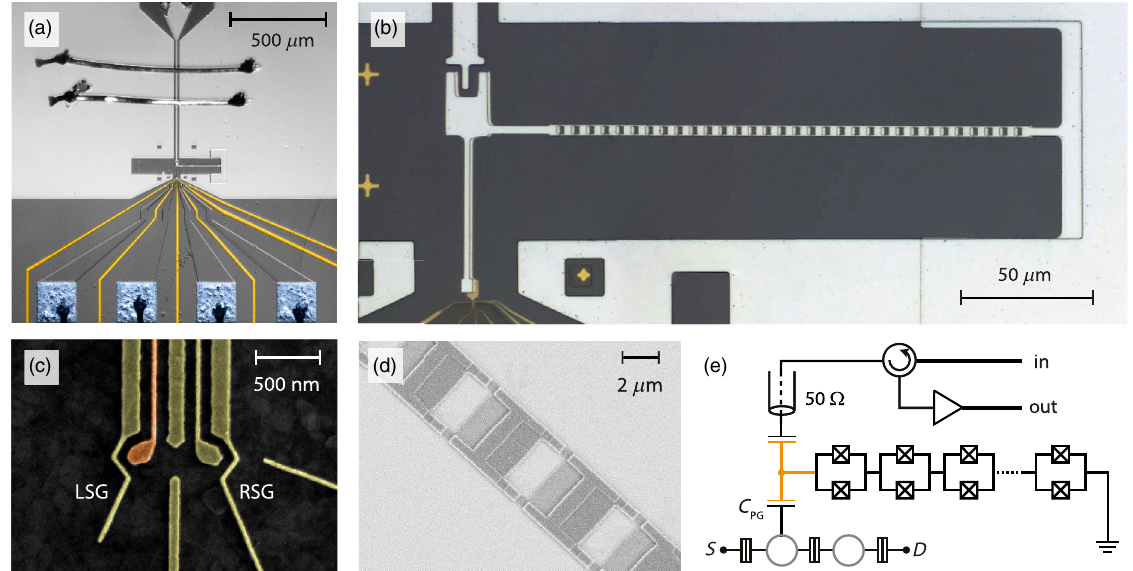
FIG. 1. Sample and simplified circuit diagram. (a) False-color optical micrograph of a representative device indicating the substrate (dark gray), the superconducting structures (light gray), the gold top gates (yellow) forming the DQD, and its source and drain leads and contacts (blue). (b) Optical micrograph displaying a SQUID array resonator (light gray) and its coupling gate to the DQD and the DQD biasing structures (yellow). (c) Electron micrograph of the DQD showing its electrostatic top gates (yellow) and the plunger gate coupled to the resonator (orange). (d) Electron micrograph of three SQUID loops (dark grey) in the array deposited on the etched GaAs heterostructure (light gray). (e) Circuit diagram schematically displaying the DQD (source contact labeled S, drain contact labeled D, and coupling capacitance C to the resonator) and essential components in the microwave detection chain (circulator, amplifier) used PG for performing reflectance measurements of the device. Boxes with crosses and rectangles indicate Josephson and normal tunnel junctions,